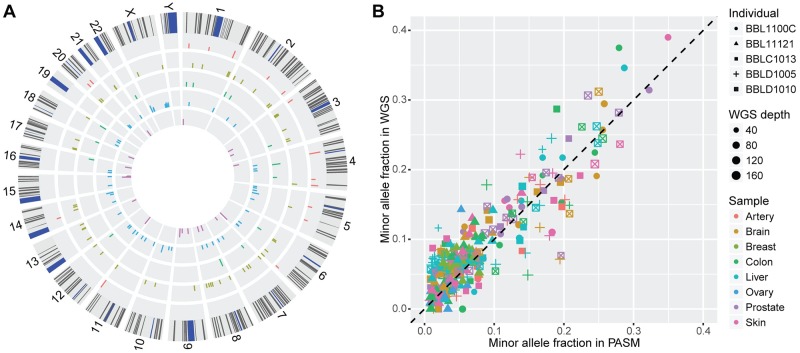
Identification and validation of pSNMs in 27 organ samples obtained from five individuals.(A) Genomic landscape of the validated pSNMs. Circos plots from outer to inner represent individuals BBL1100C, BBL11121, BBLC1013, BBLD1005, and BBLD1010, respectively. The Y axis denotes the average minor allele fraction across pSNM-carrying organs of each donor. (B) Correlation of the allele fractions estimated by whole-genome sequencing and targeted ultra-deep resequencing (PASM) of the validated sites. The shape, color, and size of the dots represent the donor and organ type carrying the pSNMs and the site-specific depth of whole-genome sequencing.